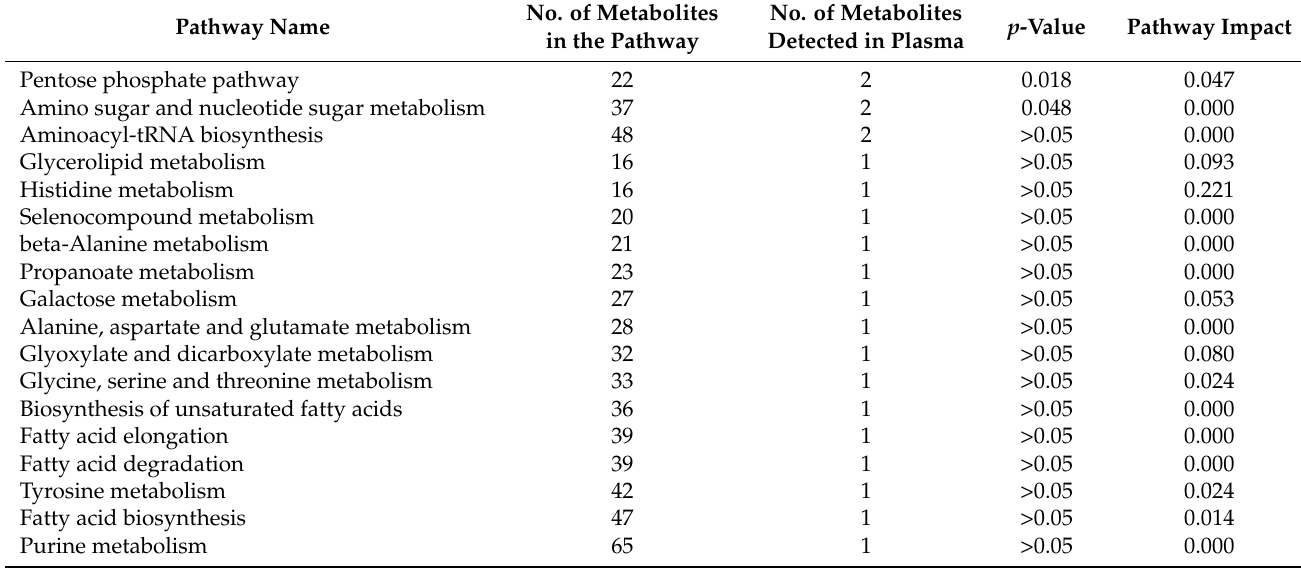
Table 4. Metabolic pathways corresponding to significant metabolites identified in plasma samples with GC–MS.